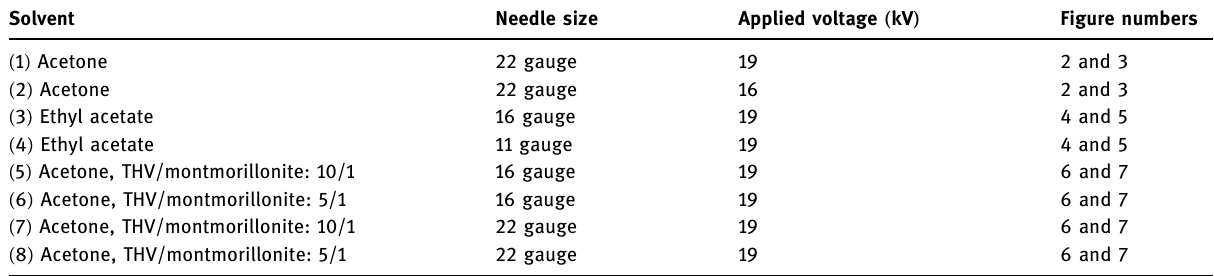
Table 1: Experimental conditions and corresponding fi gures for the results. Concentrations of THV/solvent solutions are 15 wt% Solvent Needle